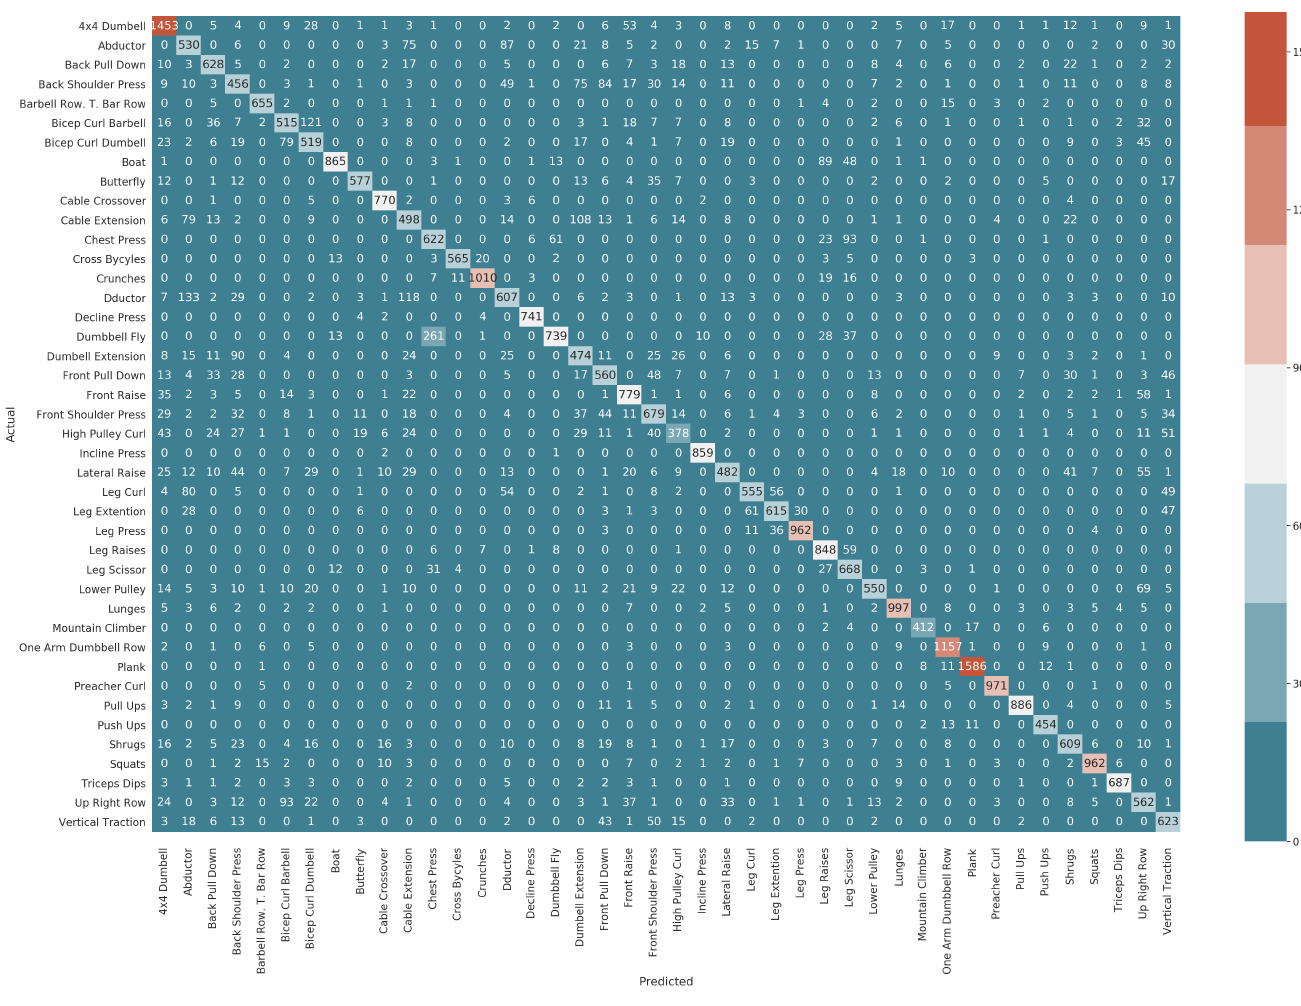
Figure 6. Accuracy and loss for one model for 42 exercises.